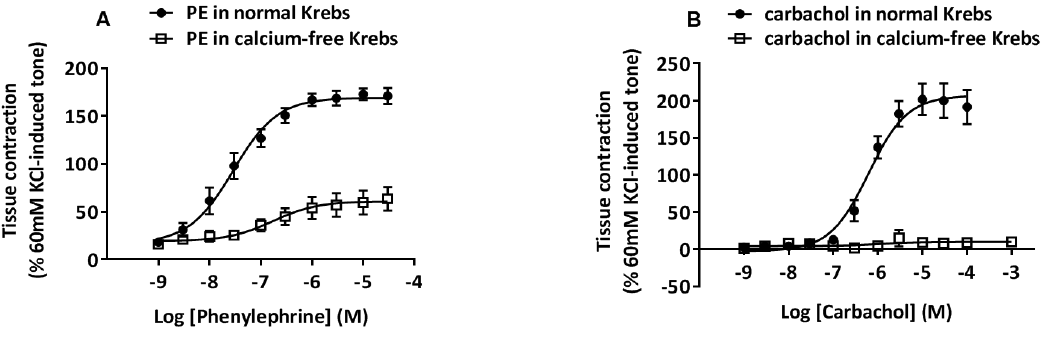
Figure 1: Effect of normal and calcium free Krebs solution on phenylephrine- or carbachol- concentration response curve on rat isolated (A) aorta and (B) trachea. Tissue responses have heen expressed as a percentage of 60mM KCl-induced contraction and are shown as means ± SEM of 3 to 8 animals.